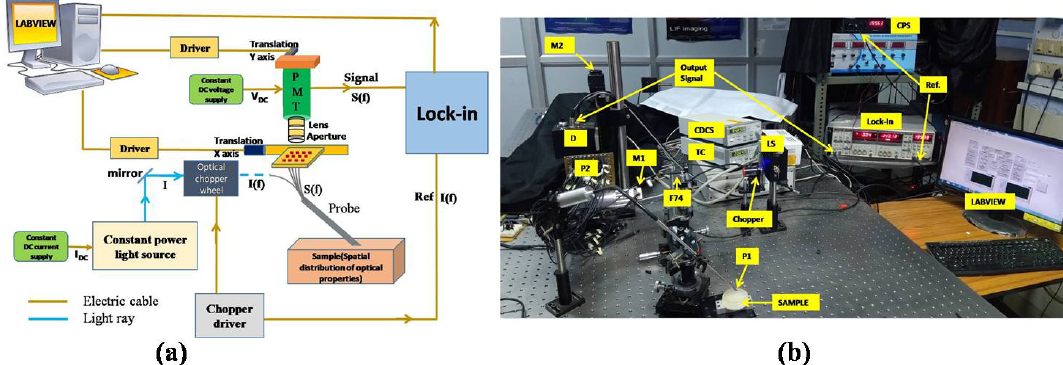
Figure 6. ( a ) Schematic diagram, and ( b ) photograph of experimental set-up used to collect steady state spatially resolved reflectance; LS—Light Source, P—Probe, D—Detector, CDCS—Constant DC current supply, TC—temperature controller, P1—Proximal end of probe, P2—Distal end of probe, M1 and M2 are stepper motors connected for x-axis and y-axis translation, CPS—Chopper power supply, F74—fiber number 74 in Figure 5e used as source